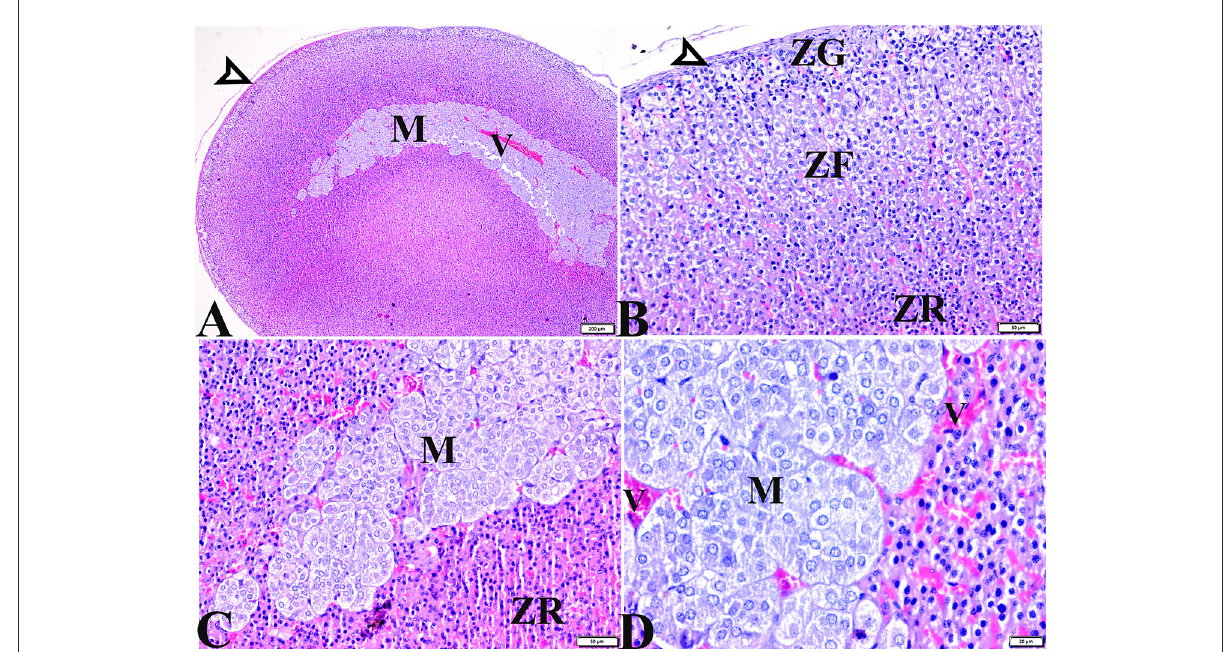
FIGURE5 Photomicrographs of adrenal gland sections from the diabetic STZ + MT-treated group showing adrenal tissue regenerations that contain (A,B) Normal thin connective tissue capsule (white arrowheads). (B) A remarkable improvement in cortical zonal partitions, a mild vacuolated ZG cell layer (ZG), mild vacuolation of the ZF cellular layer with normal arrangement (ZF), and a normal ZR cell layer (ZR). (A,C,D) Normal adrenal medulla basophilic chromaffin cells with granular cytoplasm (M). (D) Mild congestion in capillary medullary veins (V). H&E stained. The bar size is indicated under each picture.